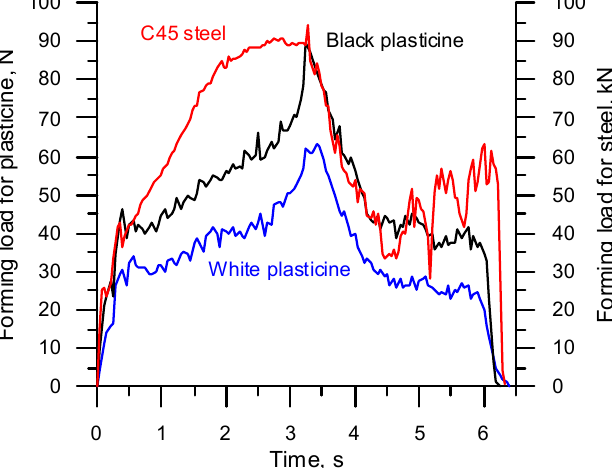
Figure 9. Balls manufactured during the research from (from the top to bottom) white plasticine ( a ), black plasticine ( b ), and C45 grade steel ( c ).